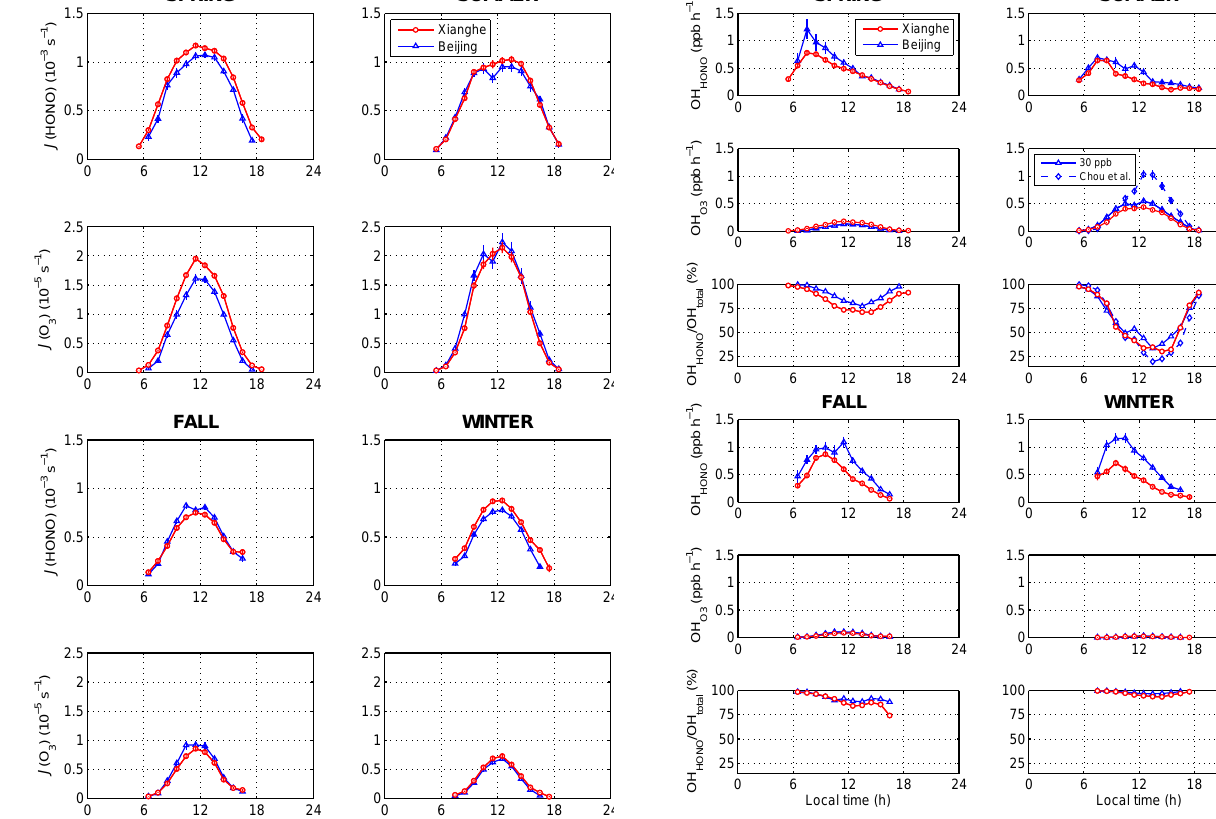
Fig. 13. Photolysis rates J (HONO) and J (O 3 → O( 1 D)) calcu- lated in the 0–200m layer for Beijing and Xianghe and averaged per season. The error bars correspond to the standard deviation of the mean.